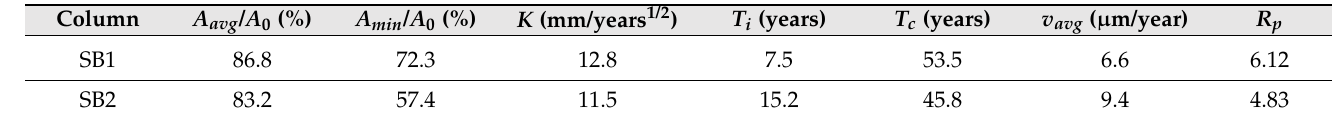
Table 7. Bars’ average and minimum residual cross-section, with respect to the original one, and corrosion attack characteristics estimated by processing the results of tomographic scans of bar SB1–SB2